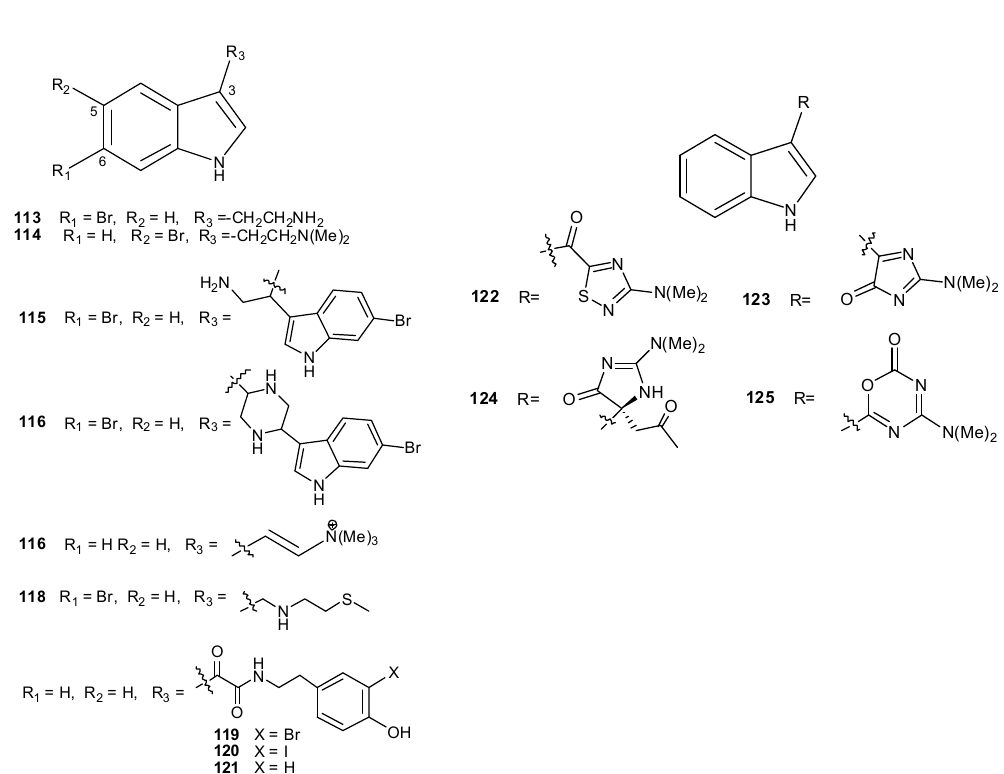
Figure 14. 3-Substituted indoles.